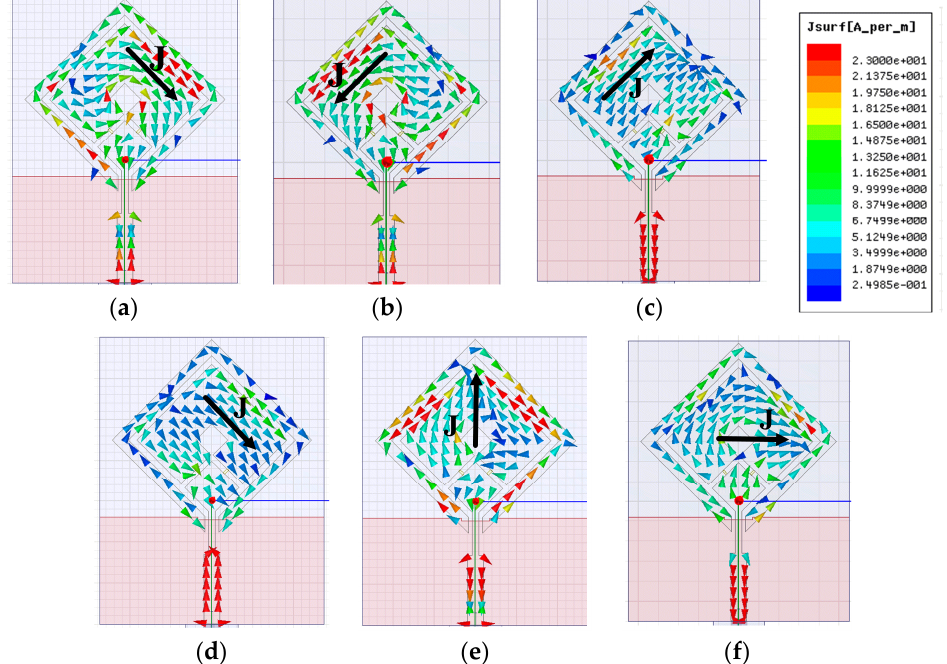
Figure 5. Current distributions to demonstrate the LHCP operation at three frequencies ( D 1 ON, D 2 OFF): ( a ) 2.5 GHz, t = 0; ( b ) 2.5 GHz, t = T/4; ( c ) 3.3 GHz, t = 0; ( d ) 3.3 GHz, t = T/4; ( e ) 3.8 GHz, t = 0; ( f ) 3.8 GHz, t = T/4.